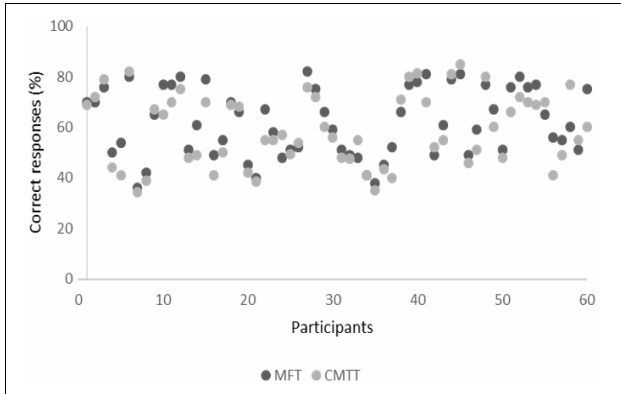
FIGURE 4 | The distribution of the 6 years-children’s spatial ability in each test.